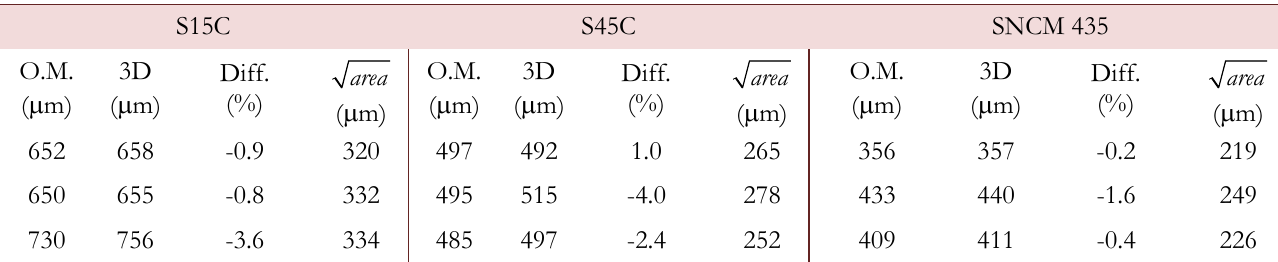
Table 1: Non-propagating crack length measured by Optical microscope (O. M.) and the analysis of 3D images (3D). The area values were obtained analyzing Z projection images (i.e. Fig. 3